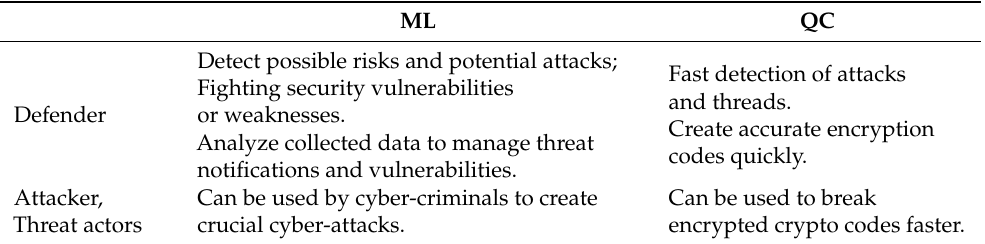
Table 1. ML and QC capabilities which challenge data science developers and researchers. ML QC Detect possible risks and potential attacks; Fast detection of attacks Fighting security vulnerabilities and threads. Defender or weaknesses. Create accurate encryption Analyze collected data to manage threat codes quickly. notifications and vulnerabilities. Attacker, Threat actors encrypted crypto codes